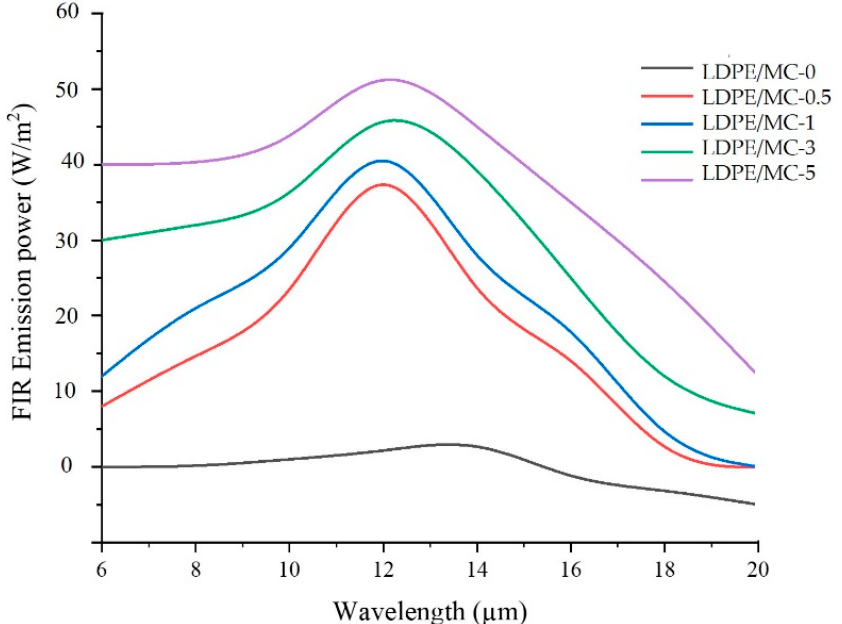
Figure 6. FIR emission spectra of the LDPE/MC composite films at various MC powder concentrations.